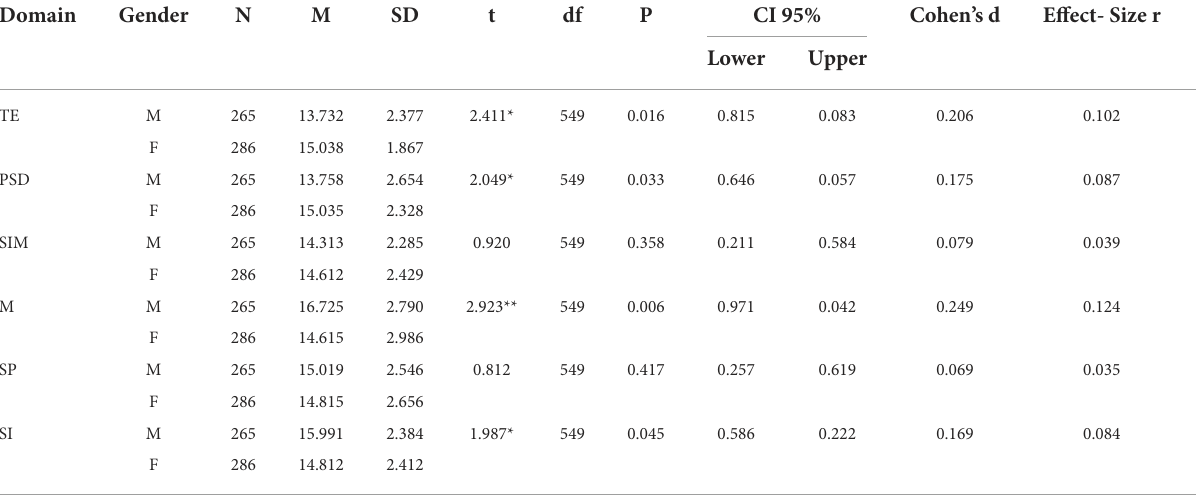
TABLE 3 Effect of gender variable on the academic expectations of students.